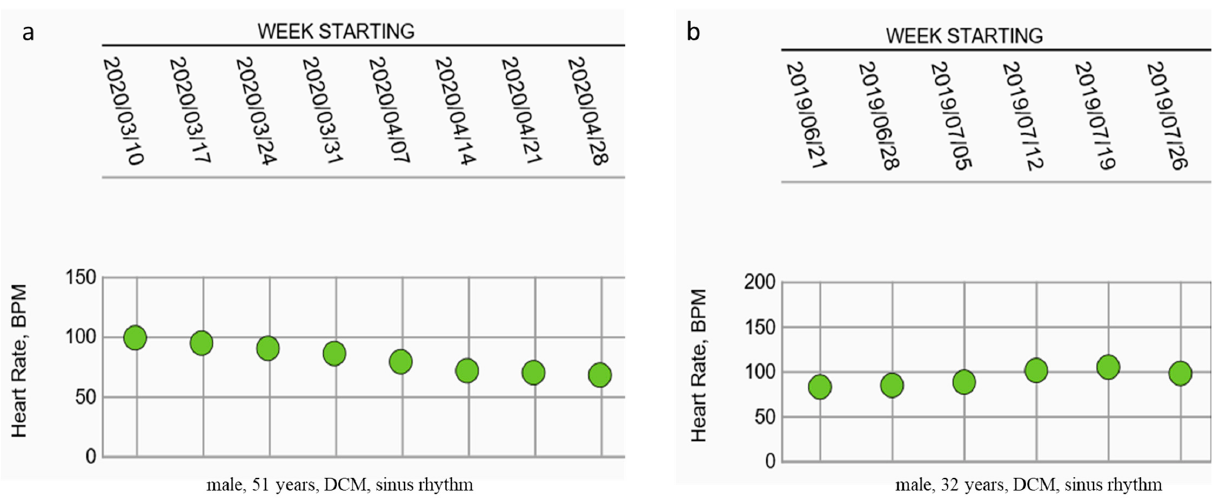
Figure 3. Examples of heart rate control with ( a ) good rate control and ( b ) heart rate overt time significantly above 70 bpm; Abbreviations: DCM, dilated cardiomyopathy; bpm, beats per minute.